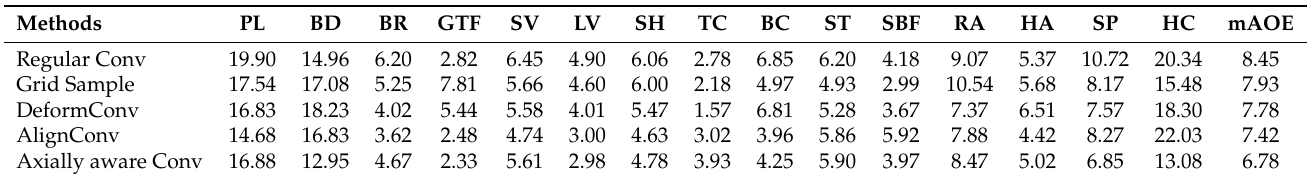
Table 4. Ablation experiment of average orientation error of mainstream feature alignment methods on DOTA1.0 dataset. All results are tested on the validation